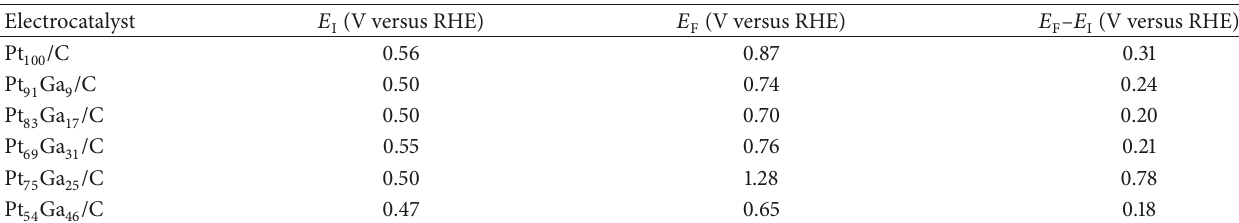
Table 4: Potential variation of PtGa/C electrocatalysts after 15 hours of electrolysis in ethanol 1.0 molL −1 at 3.0 mAcm −2 .